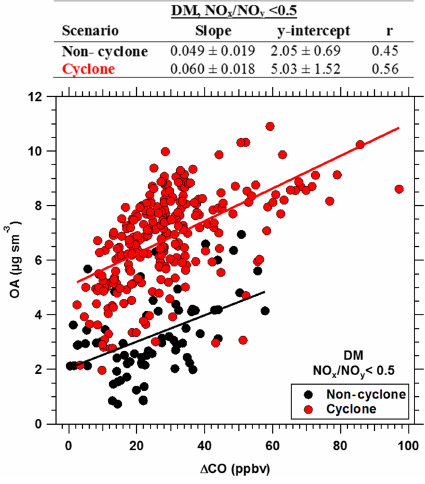
Figure 12. Scatterplot of OA (µgsm − 3 ) vs. (cid:49) CO (ppbv) under the most aged air masses (NO x /NO y < 0.5) in DM for non-cyclone (black) and cyclone (red) days. Slope and intercept values are based on the ODR error-weighted (30% OA, 3% CO) fits, while the cor- relation coefficients are based on the linear least-squared regression fits.